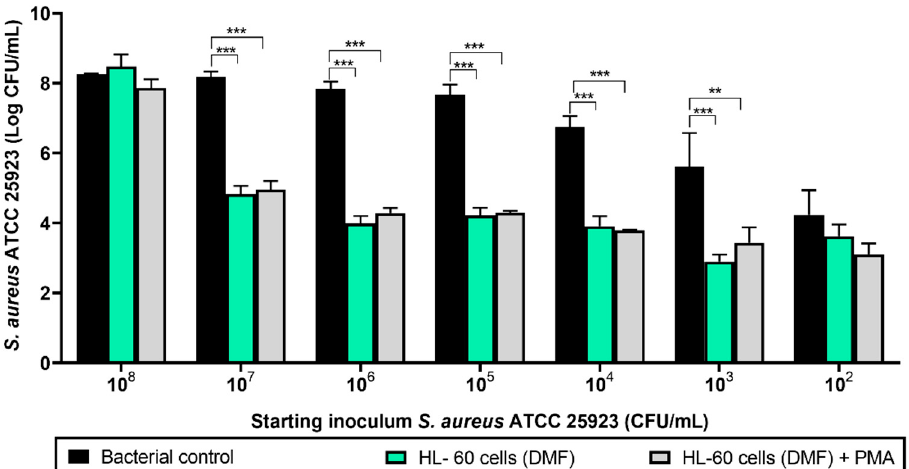
Figure 2. Viable counts of 24-hour-old biofilms formed by different concentrations of S. aureus ATCC 25923 cocultured with HL-60 cells on 96-well microplates. Black columns represent the bacterial control (viable attached cells in the absence of HL-60 cells). Green columns show the coculture of S. aureus ATCC 25923 with HL-60 cells differentiated with N , N -dimethylformamide (DMF). Gray columns show the coculture of S. aureus ATCC 25923 with HL-60 cells differentiated with DMF and activated with phorbol 12-myristate 13-acetate (PMA). Values are means and SD of three independent experiments ( *** p < 0.001; ** p < 0.01).